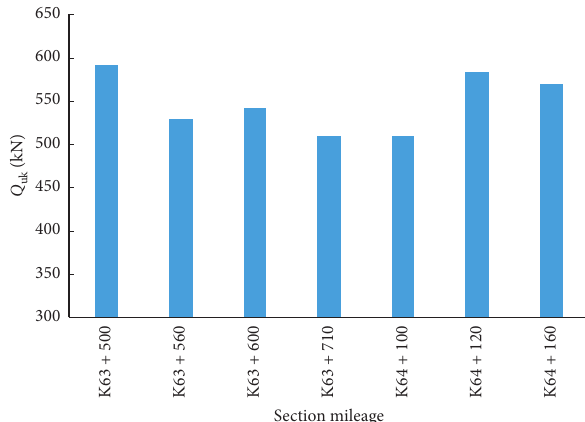
Figure 8: Histogram of Q